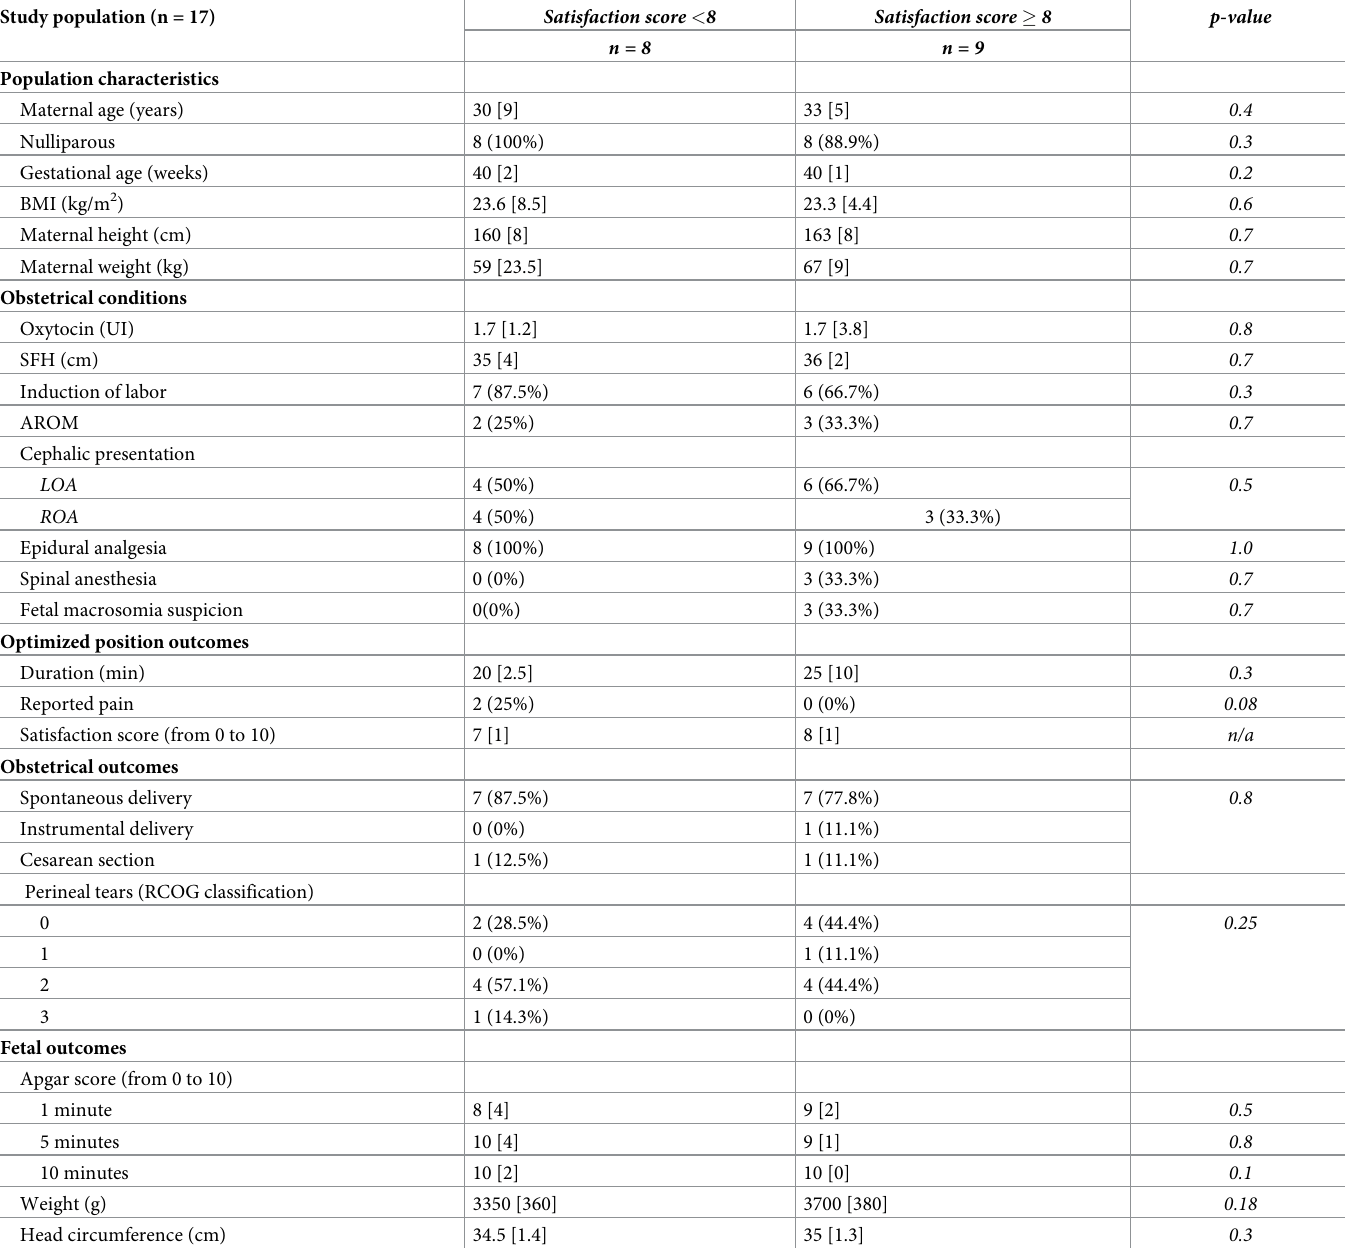
Table 3. Comparison of population characteristics, obstetrical conditions and obstetrical outcomes between women with higher and lower satisfaction scores regarding the optimized